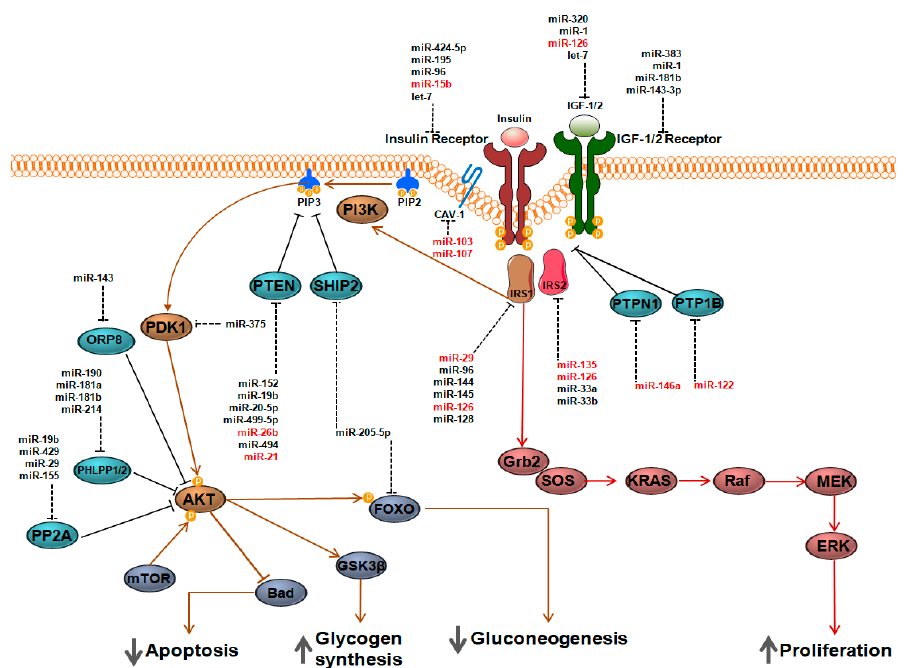
Figure 1. Expression of Insulin/IGF signaling components is modulated by miRNAs. Insulin Receptor (INSR) and Insulin-like Growth Factor (IGF) receptors are preferentially located into plasma membrane macrostructures (caveolae) characterized by caveolins proteins (e.g., Caveolin-1) and lipids, which stabilize their structures. Ligands binding to their specific receptors induces the activation of phosphatidylinositol 3-kinase (PI3K) and of other downstream components, mediated by the recruitment of scaffold elements (e.g., IRS1 and IRS2 protein members). PI3Kactivation, which triggers phosphorylation of PIP2 into PIP3, regulates insulin metabolic effects by phosphorylation of AKT through several intermediate kinases (e.g., PDK1), thus resulting into increased glucose uptake and glycogen synthesis and decreased gluconeogenesis. On the other side, insulin signal transduction induces a pro-survival status through the direct inhibition of Bad (pro-apoptotic) and activation of mitogen-activated protein kinase (MAPK) pathway (proliferation). MiRNAs negatively regulate multiple target genes involved in insulin/IGF signaling pathway and are indicated as dashed lines. MiRNAs targeting insulin signaling factors and identified as deregulated in insulin sensitive tissues in metabolic disease in man are depicted in red. The orange rounds with P in it represent phosphate groups; the grey arrows pointing down indicate negative regulation of those specific process and the grey arrows pointing up indicate positive regulation of those specific process. Factors reported in brown represent the main effectors of insulin signaling metabolic activations; factors reported in dark red represent the activated effectors acting on proliferation and pro-survival cues; factors reported in light blue represent phosphatases and kinases; factors reported in dark blue represent interactors /effectors of Akt signaling. Note: PTEN (Phosphatase And Tensin Homolog), GAV (Gill-associated Virus), PTPN1 Protein Tyrosine Phospatase, Non-receptor type 1, PTP1B Protein-tyrosine phosphatase 1B, PDK1 (Phosphoinositide-dependent kinase 1), ORP8 (OSBP-related protein 8), PHLPP1/2 (Pleckstrin Homology Domain Leucine-rich Repeat Protein Phosphatase1/2), PP2A (Protein Phosphatase 2 A), AKT (Protein Kinase B), mTOR (mammalian Target of Rapamicin), GSK3 β (Glycogen Synthase Kinase 3 β ), FOXO (Forkhead box O), SOS (Son of Sevenless), KRAS (Ki-ras2 Kirsten rat sarcoma viral oncogene homolog), MEK (Mitogen-activated protein kinase kinase), ERK (Extracellular Signal-Regulated Kinase).